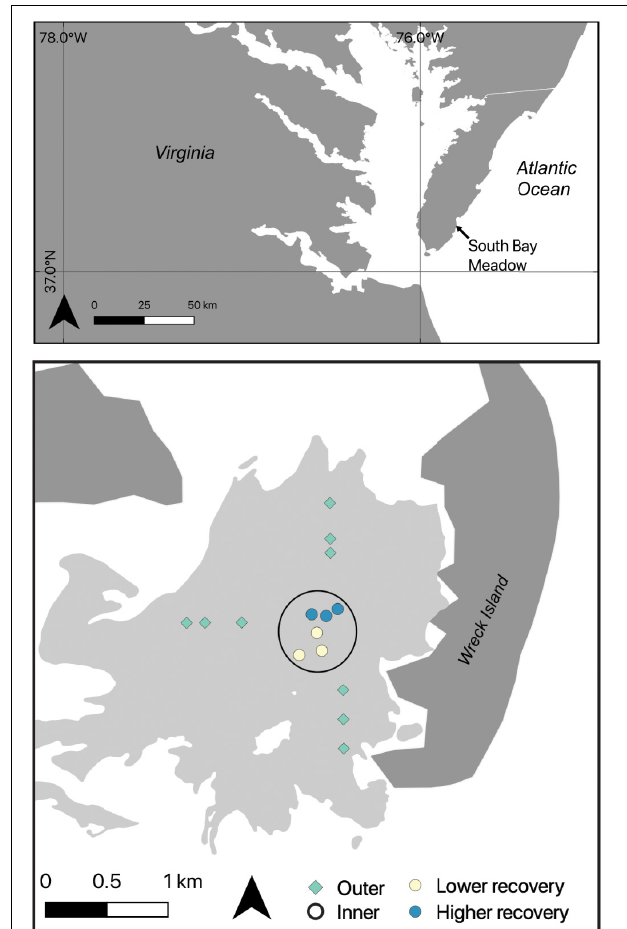
FIGURE 1 | Map of the study system, with the seagrass meadow extent shown in light gray, the barrier islands shown in dark gray, and sampling sites as colored symbols. The six inner meadow sites are shown as circles; the nine outer sites are shown as diamonds. Colors represent the degree of impact from the heat wave in 2015; yellow sites had lower recovery, blue sites had higher recovery, outer sites are green. Sites within the black circle were long-term monitoring sites